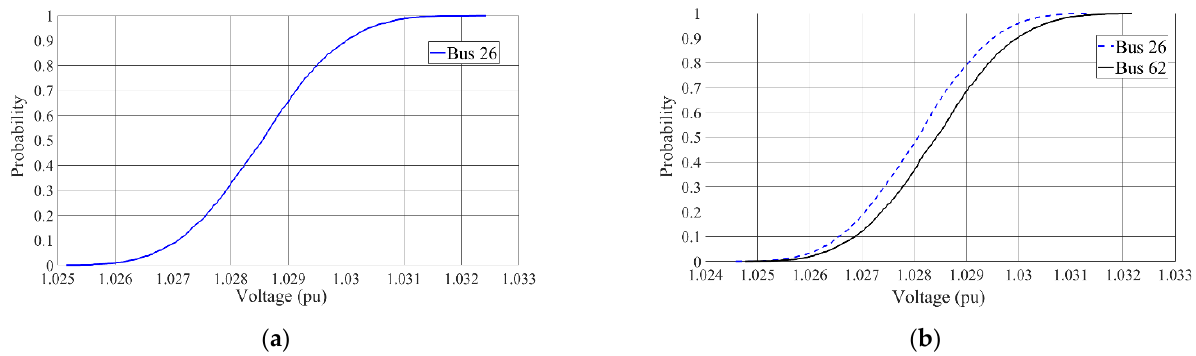
Figure 5. Voltage results obtained by the CC voltage control framework: ( a ) CC-Method I; ( b ) CC-Method II.